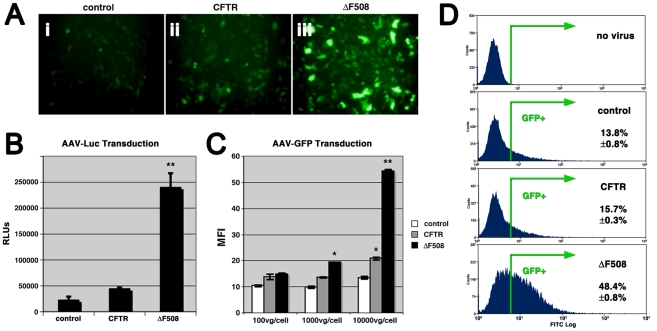
Cells expressing misfolded ΔF508-CFTR are more permissive to AAV infection.A. Images of GFP-positive cells after administration of recombinant AAV (AAV2, 1,000 vg/cell: eGFP transgene) to BHK-21 cells (panel i), BHK-21 cells overexpressing CFTR (ii), or BHK-21 cells overexpressing ΔF508-CFTR (iii). B. Luciferase activity of cells after transduction by AAV (AAV2, 1,000 vg/cell: Luc transgene) in control BHK-21 cells, or cells expressing CFTR, or expressing ΔF508-CFTR. C. Flow cytometry analysis of AAV transduction at increasing particle numbers showing mean fluorescence intensity (MFI) of GFP expression from positive cells after inoculation with AAV2-GFP at 100, 1000, or 10000 vg/cell. D. Plots show percent of GFP-positive cells after infection with AAV2-GFP (1,000 vg/cell) in control BHK-21 cells, CFTR cells, or ΔF508-CFTR cells. Samples that were statistically different from controls are marked (*p<0.05; **p<0.01).